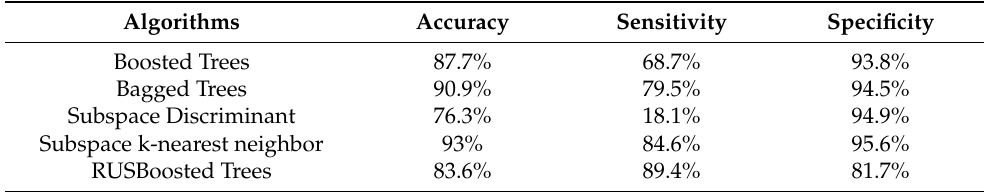
Table A7. Detailed classification performance of ensemble